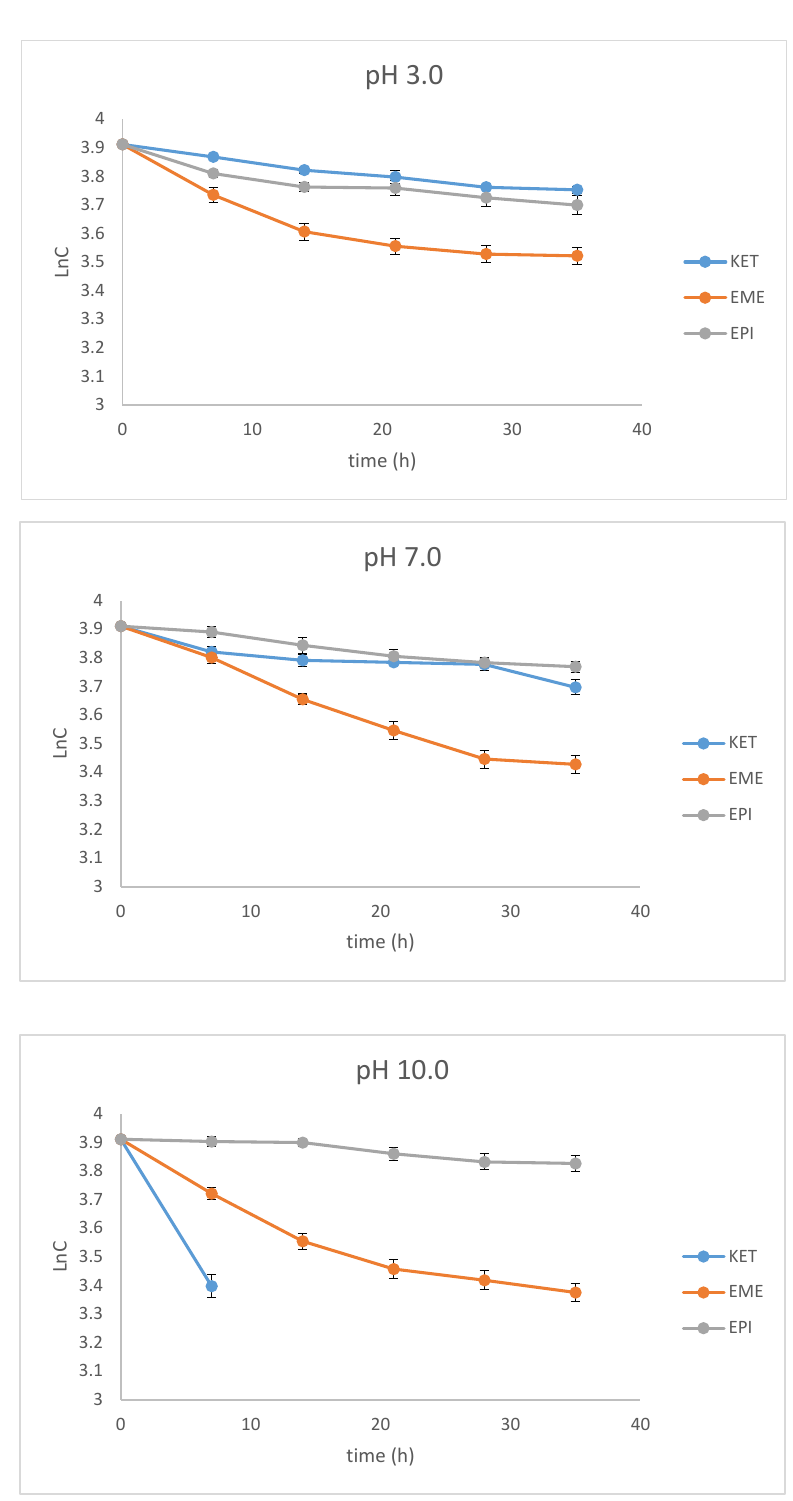
Figure 4. First-order plots of the degradation of emedastine (EME), epinastine (EPI), and ketotifen (KET) in buffer solutions ( n = 3, mean ± SD).